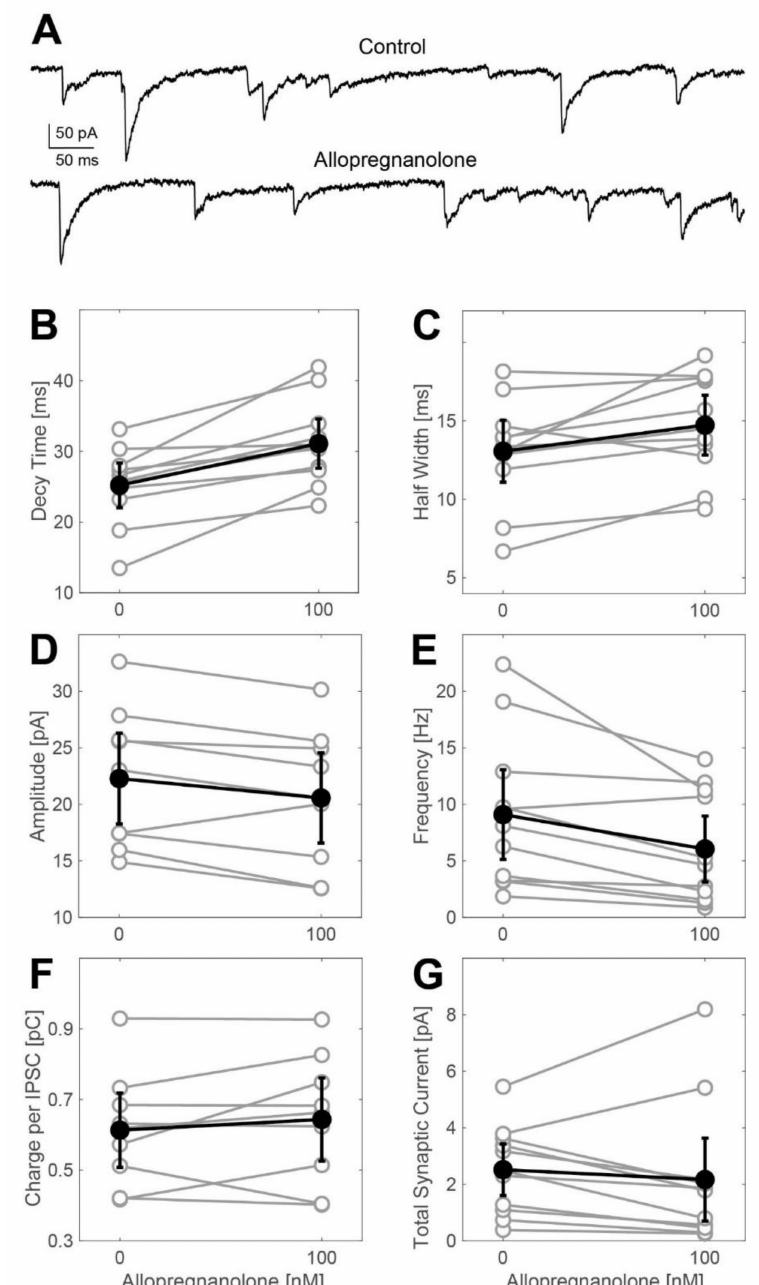
Figure 2. E ff ects of allopregnanolone (100 nM) on phasic currents in spinal neurons in the ventral horn. ( A ) Original whole-cell voltage-clamp recording from a cultured spinal slice in the absence (upper trace) and presence (lower trace) of ALLO (100 nM). ( B – G ) Summary of the actions of ALLO (100 nM) on IPSC decay time ( B ), width ( C ), amplitude ( D ), frequency ( E ), charge per IPSC ( F ), and total synaptic current ( G ). All data are given as the mean including the 95% confidence interval. ALLO at 100 nM induced a significant increase in the IPSC decay time ( B ) from 25.2 (22.03, 28.35) ms to 31.1 (27.6, 34.58) ms ( n = 11, p = 0.0035, t -test). The same e ff ect could be detected when analyzing the width of